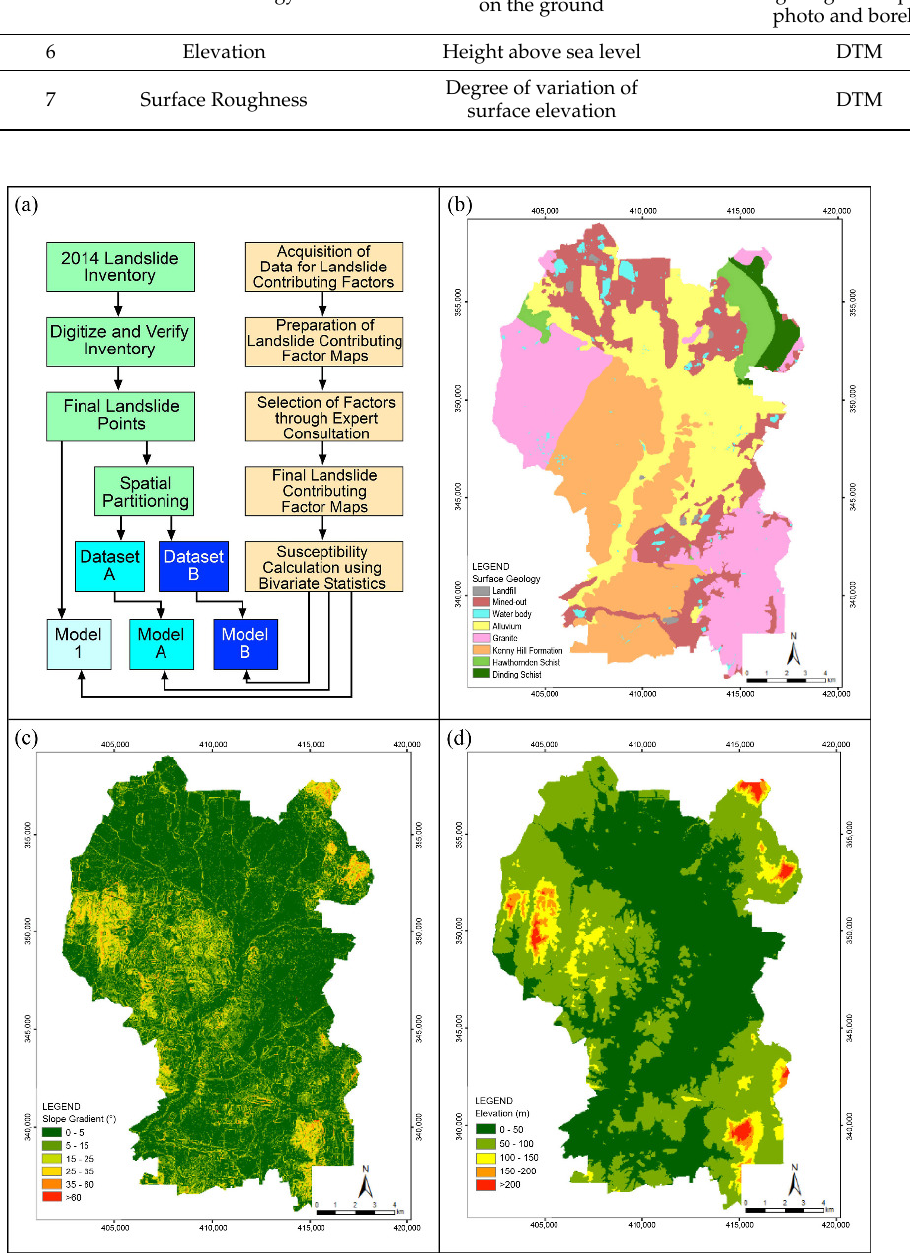
Figure 2. Seven landslide conditioning factors were selected according to the steps highlighted in the flow chart ( a ). The factors are surface geology ( b ), slope gradient ( c ), and elevation ( d ).